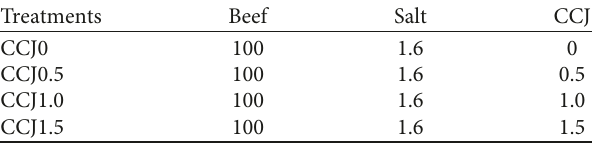
Table 1: Formulation (g) of beef burgers.